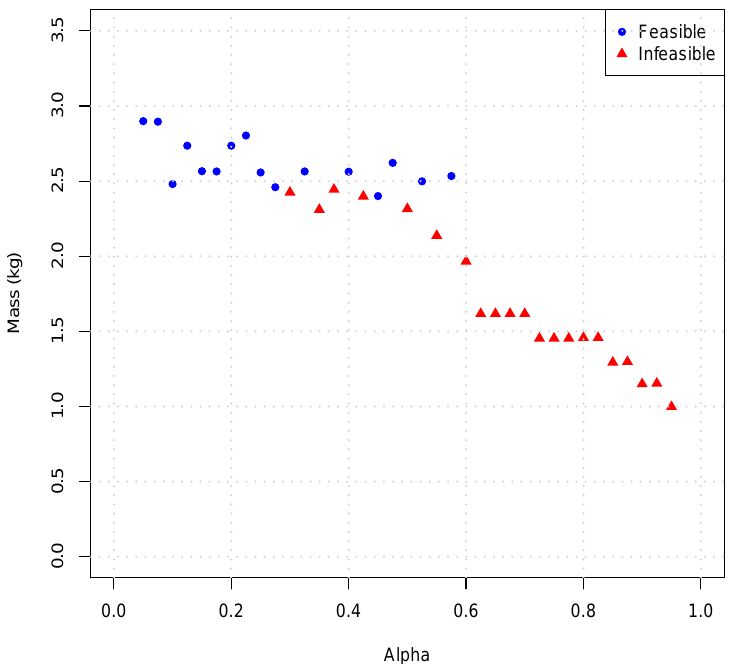
Figure 18. First DOE: optimum mass for different α values calculated by the FE model, after rounding the variables at the optimal points from the metamodel.